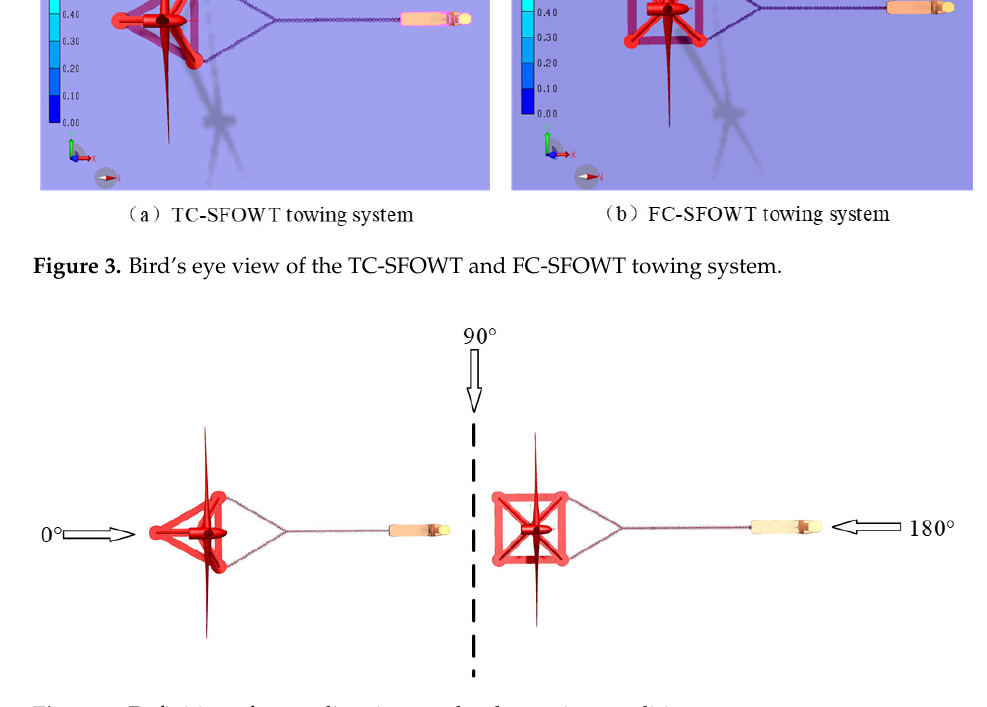
Figure 4. Definition of wave directions under the towing condition.